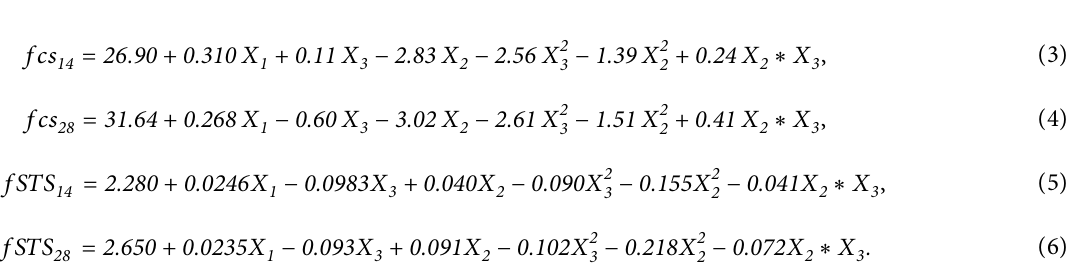
Figure 3: Concrete split tensile strength with jute fibres, bamboo fibres, and silica